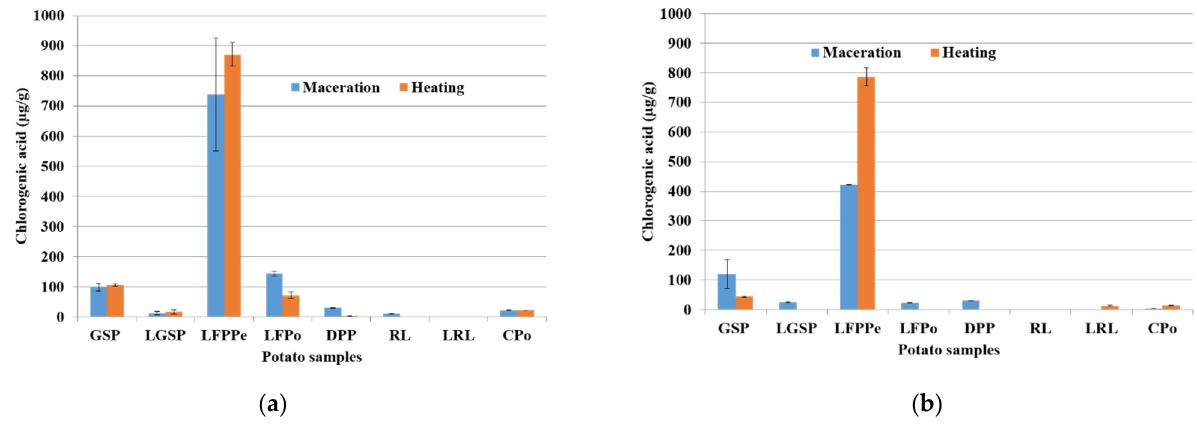
Figure 3. Effect of potato co-products at two extraction methods on chlorogenic acid content, ( a ) MeOH: H 2 O; 4:1 and ( b ) EtOH: H 2 O; 4:1 extracts.